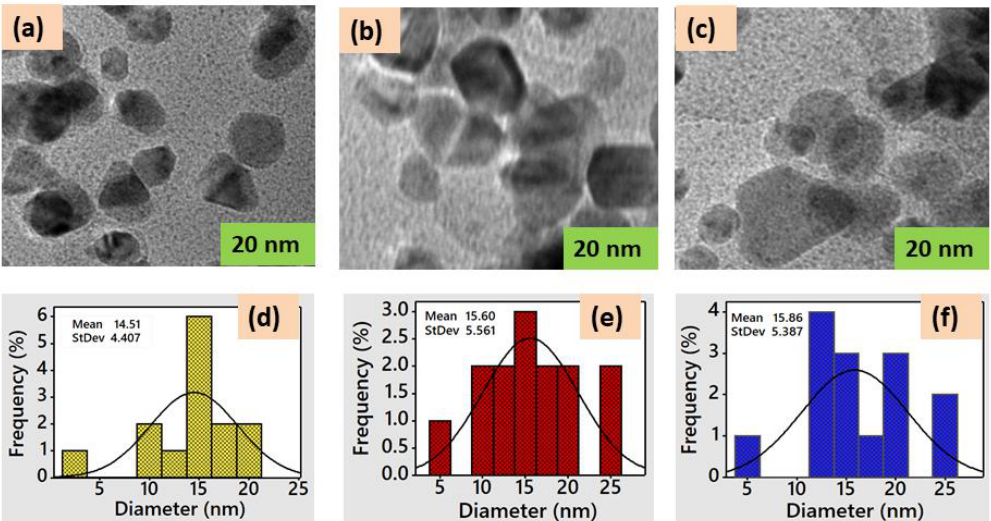
Figure 2. TEM image of: ( a ) yellow G-AgNPs; ( b ) red G-AgNPs; ( c ) blue G-AgNPs; and their respective size distributions ( d – f ).